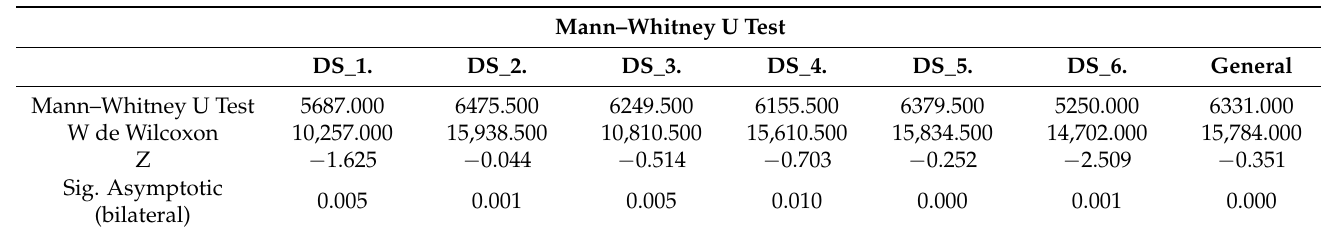
Table 8. Mann–Whitney U Test with a no COVID-19–COVID-19 grouping item (post-test).